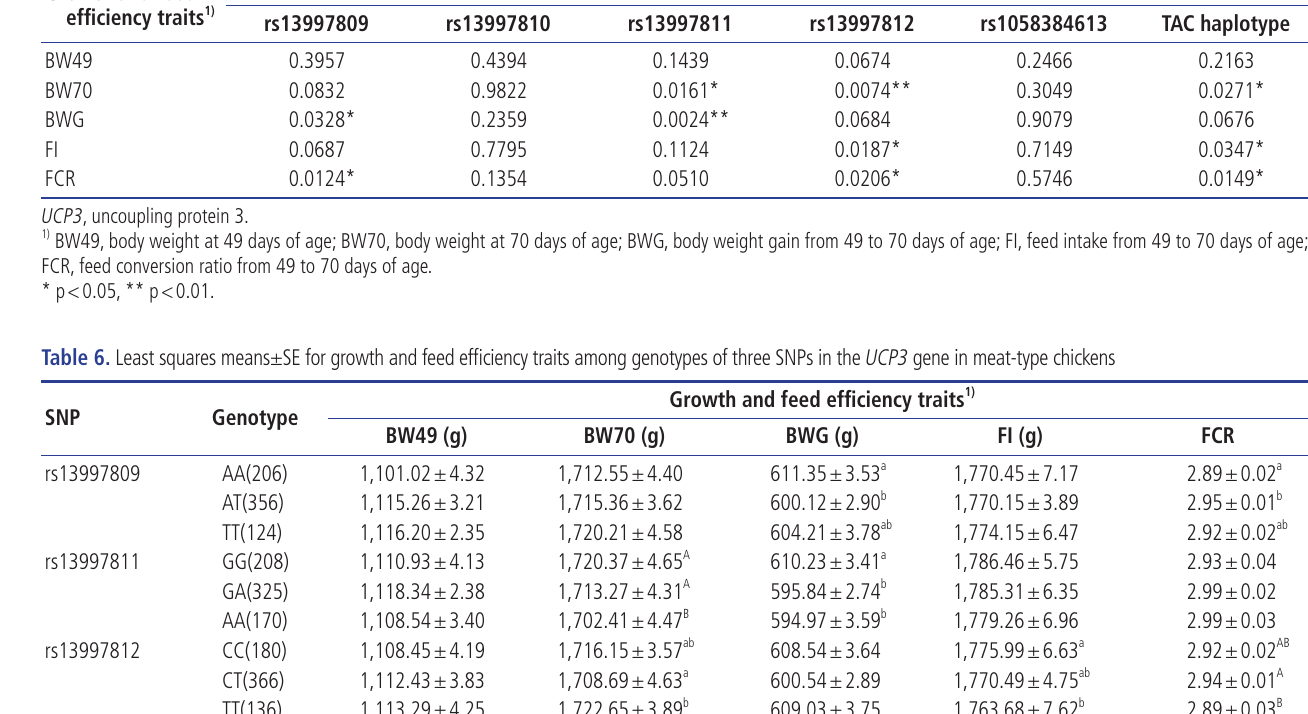
Table 4. Association analysis of UCP3 polymorphisms and haplotypes with growth and feed efficiency traits in meat-type chickens Growth and feed efficiency traits 1)